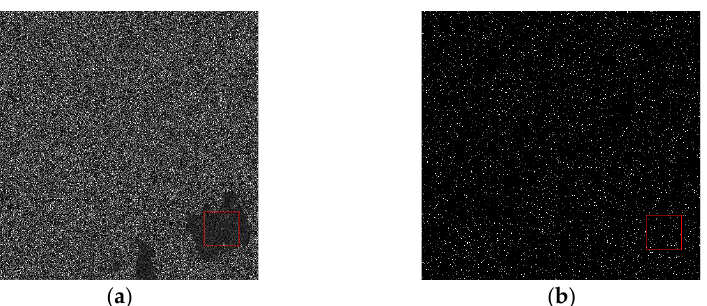
Figure 7. Difference between the noise obtained by DnCNN and the truth for Figure 1e: ( a ) Texture structure is left in the noisy image with σ 2 = 0.04 estimated by DnCNN; ( b ) True noise distribution with σ 2 = 0.005.